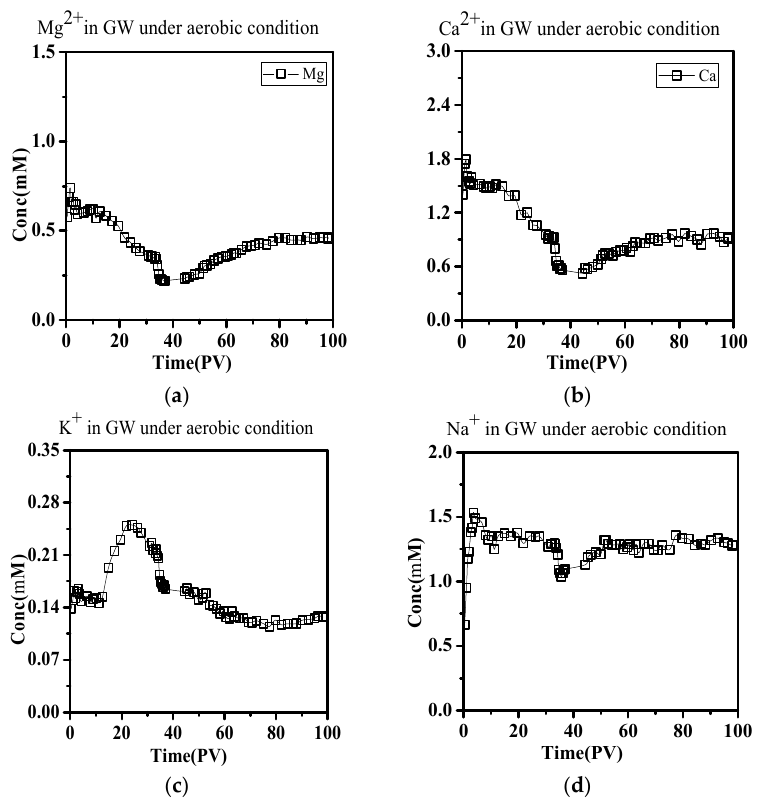
Figure 4. The ion exchange kinetic curves of Mg 2+ ( a ), Ca 2+ ( b ), K + ( c ) and Na + ( d ) with NH 4+ in SGW under aerobic conditions.